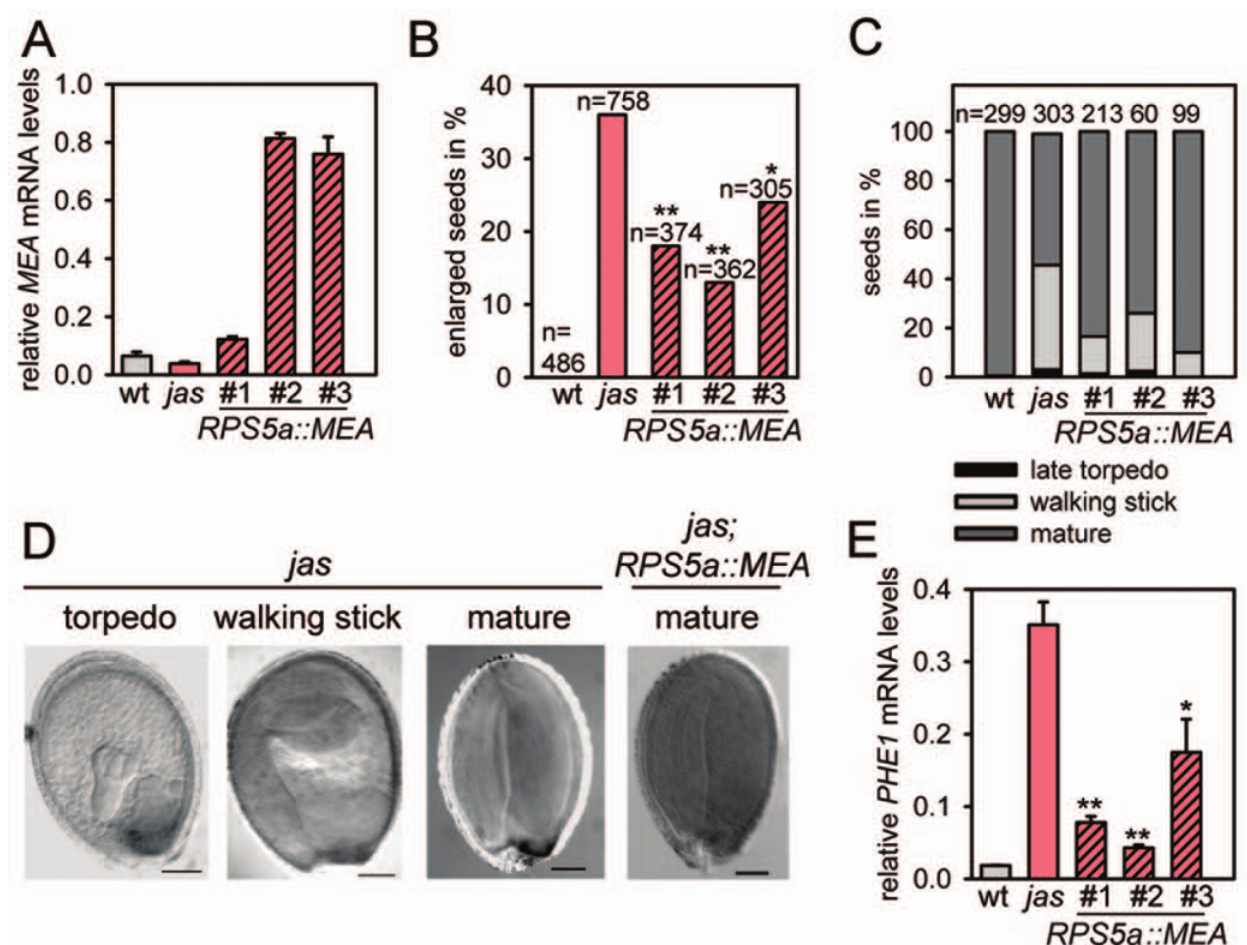
Figure 7. Overexpression of MEA partially complements developmental defects of triploid seeds. (A) Quantitative RT–PCR analysis of MEA expression in seeds of wild type, jas and transgenic lines jas ; RPS5::MEA/ + at 7 DAP. Error bars, s.e.m. (B) Number of enlarged seeds in wild-type, jas and transgenic lines jas ; RPS5::MEA/ + . Significance was determined by Chi-square test comparing normal and enlarged seeds of jas and transgenic lines. ** P , 0.001, * P , 0.01, 1 d.f. Numbers above bars indicate numbers of scored seeds per genotype. (C) Distribution of seed developmental stages in jas and transgenic lines jas ; RPS5::MEA/ + determined at 10 DAP. Numbers above bars indicate numbers of scored seeds per genotype. (D) Progression of embryo development in jas;RPS5a::MEA lines. Images correspond to developmental stages quantified in (C). Scale bars, 100 m m. (E) Quantitative RT-PCR analysis of PHE1 expression in seeds of wild-type, jas and transgenic lines jas ; RPS5::MEA/ + at 7 DAP. Error bars, s.e.m. Significance was determined by two-tailed Student’s t-test. **P , 0.001, *P , 0.01. DAP; days after pollination. wt; wild